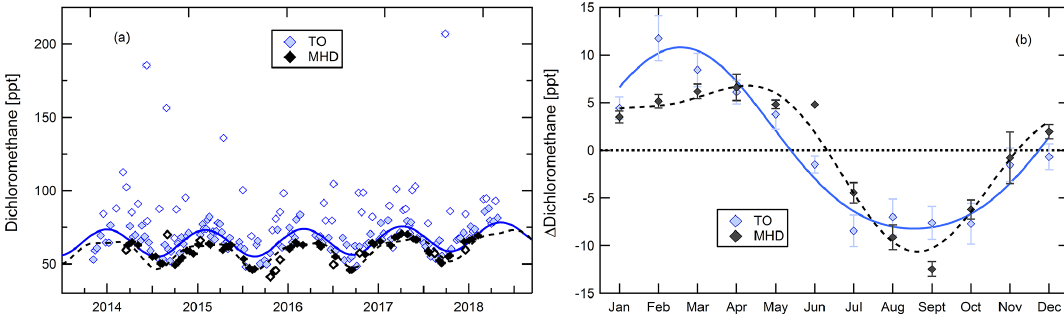
Figure 9. Time series (a) and seasonality (b) of dichloromethane at Taunus Observatory (blue) and at Mace Head (black). Open symbols in the time series indicate samples flagged as outliers. Seasonality is shown as the difference of the monthly mean to the mean of the full detrended baseline time series.